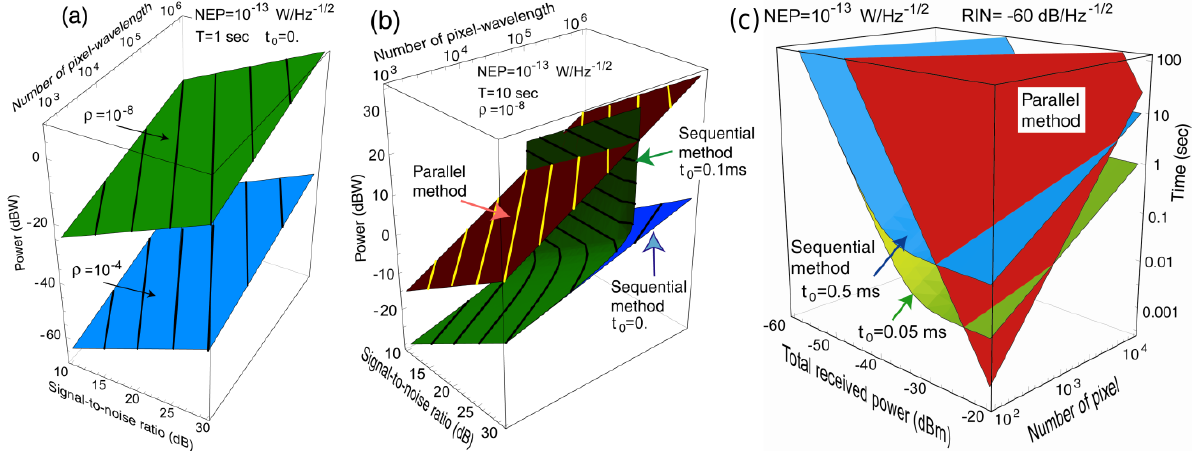
Figure 3. (a) Left: Transmitter power required as a function of pixel-wavelength product number and desired SNR for two return factors  = 10 -8 and 10 -4 , with 1-sec total data acquisition time with no dead time between pixel ( t = 0). (b) Right: Comparison of power 0 requirement for sequential scanning vs. parallel staring method of imaging. Depending on dead time t , each method can be best for certain condition. For both, contour lines of 0 5-dBW apart are also shown. (c) Time needed to acquire a complete multispectral image as a function of received power and number of pixels. For low received power, the sequential scanning method is superior. But the parallel staring method is better with ample signal power. The noise model includes laser relative intensity noise (RIN) as indicated.